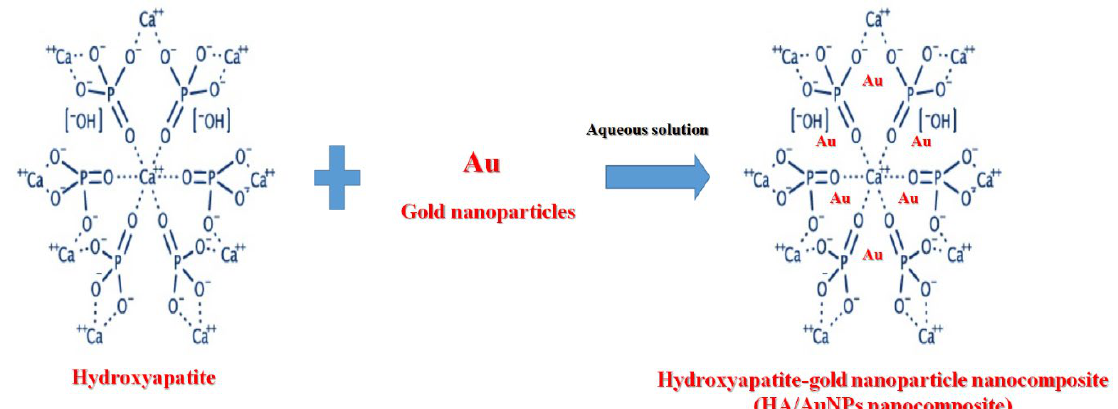
Scheme 4. Schematic representation for the synthesis of HA/Au nanocomposite.